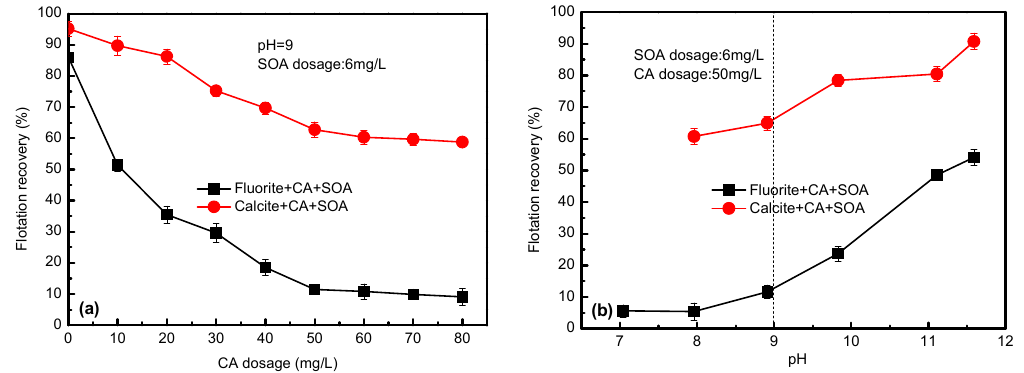
Figure 4. Effect of CA dosage ( a ) and pH ( b ) on flotation recoveries of calcite and fluorite minerals using SOA as the collector and CA as the depressant.